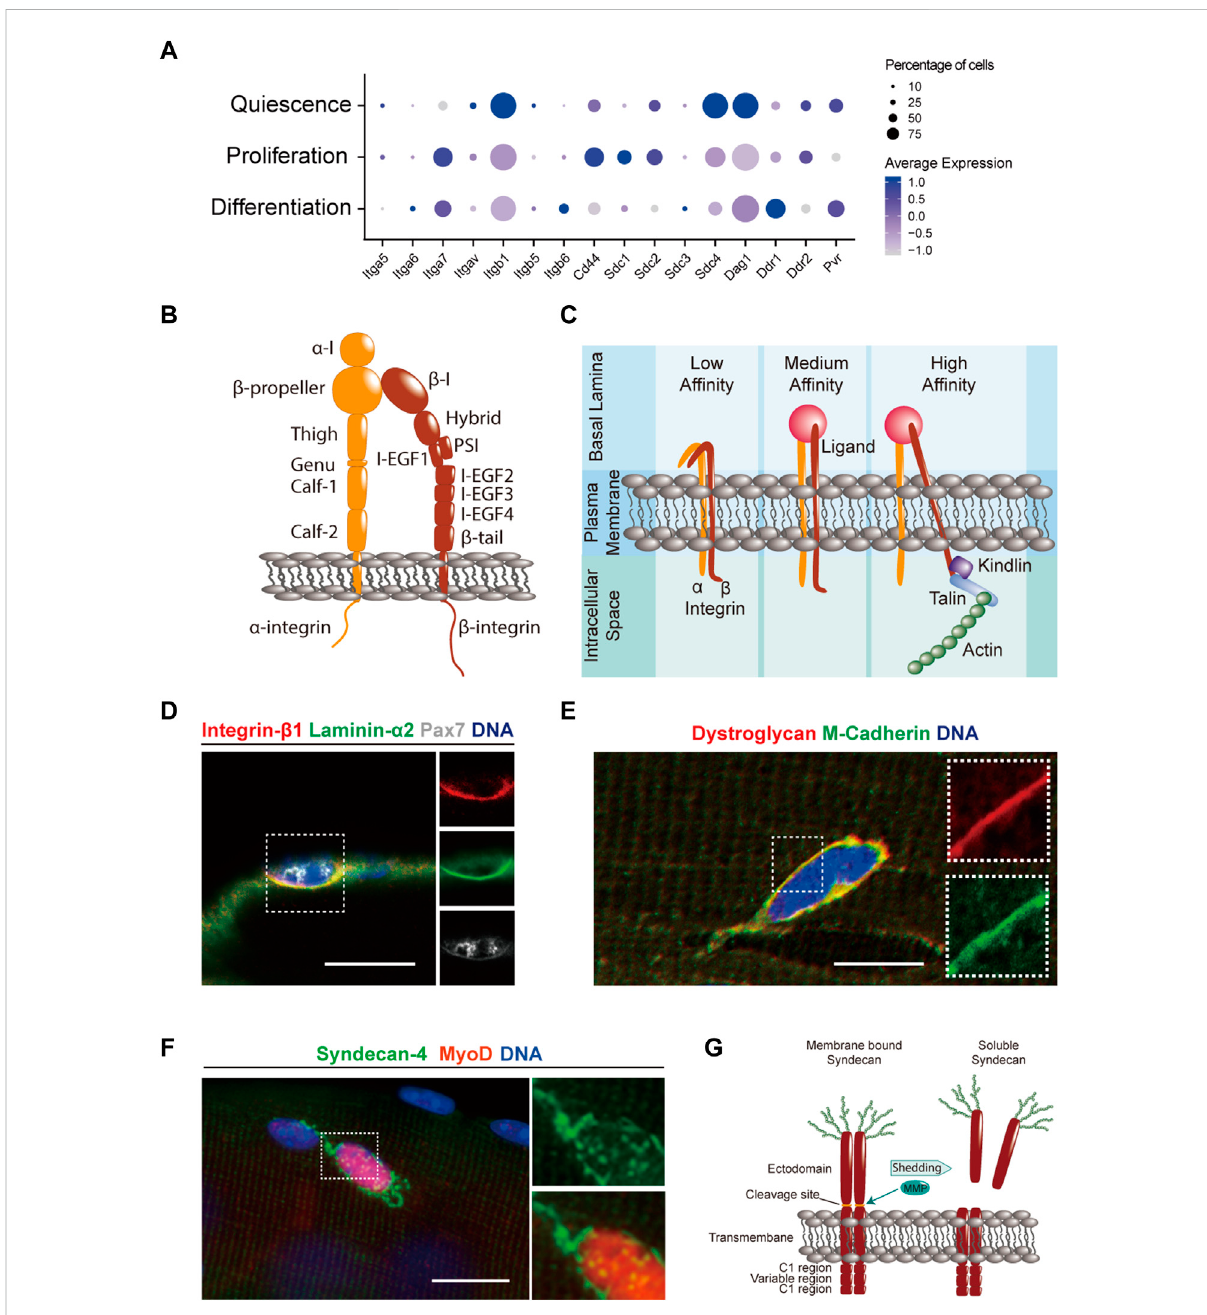
FIGURE 2 Transmembrane ECM components and receptors in MuSCs. (A) Dot plot of single cell RNA-sequencing data (Oprescu et al., 2020) obtained fromtheGeneExpressionOmnibus(GEO)database(Barrettetal.,2013)fromuninjuredandregeneratingskeletalmousemuscleat5 dayspostinjury that was generated usingSeurat 4.0.5. (Hao et al.,2021). Genescoding for ECM interacting transmembraneproteins wereselectedbasedon theGO terms “ adhesion receptor function ” in the adhesome data base and “ ECM receptors ” in the reactome data base (Zaidel-Bar et al., 2007; Winograd-Katz et al., 2014; Griss et al., 2020). The data for quiescence was obtained from uninjured muscles, while proliferation and differentiation were de fi ned based on the presence or absence of expression of genes such as Pax7 , MyoD , MyoG , and MKI67 at 5 days post injury. Only genes signi fi cantly expressed by atleast 10% of MuSCs are shown. (B) Scheme showing the domain structure of the integrin- α and - β subunits. (C) Scheme illustrating how integrins transition from their low-to high-af fi nity state upon multivalent ligand binding and intracellular stabilization by focal adhesion molecules. (D) Immunostaining showing integrin β 1 (red), laminin α 2 (green), Pax7 (white), and DNA (blue) in a MuSC on a manually teased mouse muscle fi ber bundle preparation. (E) Immunostaining showing dystroglycan (red), M-cadherin (green), and DNA (blue) in a MuSC on an enzymatically isolated single mouse muscle fi ber. (F) Immunostaining showing syndecan-4 (green), MyoD (red) and DNA (blue) in MuSCs on an enzymatically isolated single mouse muscle fi ber after 24 h of culture. (G) Scheme showing the domain structure of syndecan dimers in their membrane bound and soluble forms. Matrix metalloproteinases (MMPs) cleave membrane syndecans in a process called “ shedding ” and release the extracellular domain into the surrounding ECM. Scale bars = 20 μ m (D,E) , and 10 μ m (F)